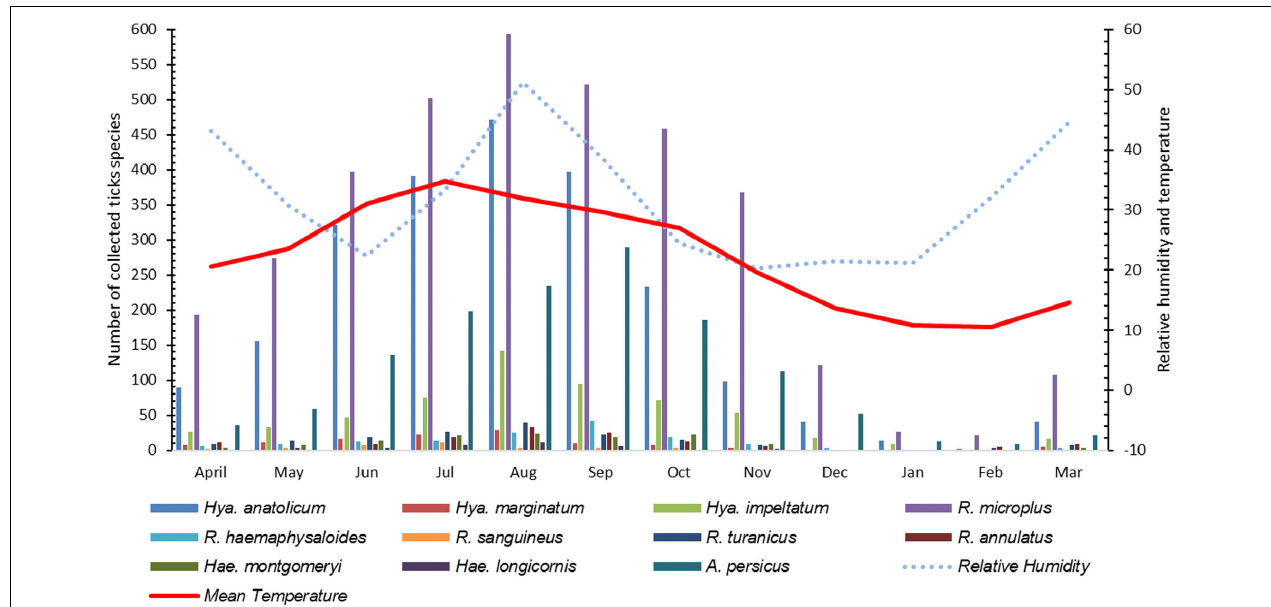
FIGURE 7 | Seasonal dynamics of various tick species recorded during this study.